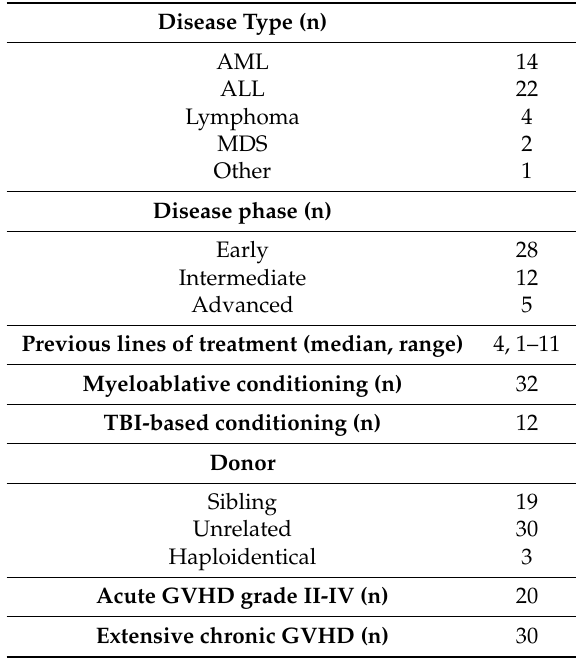
Table 1. Patients’ pre-transplant and transplant characteristics ( n = 45).